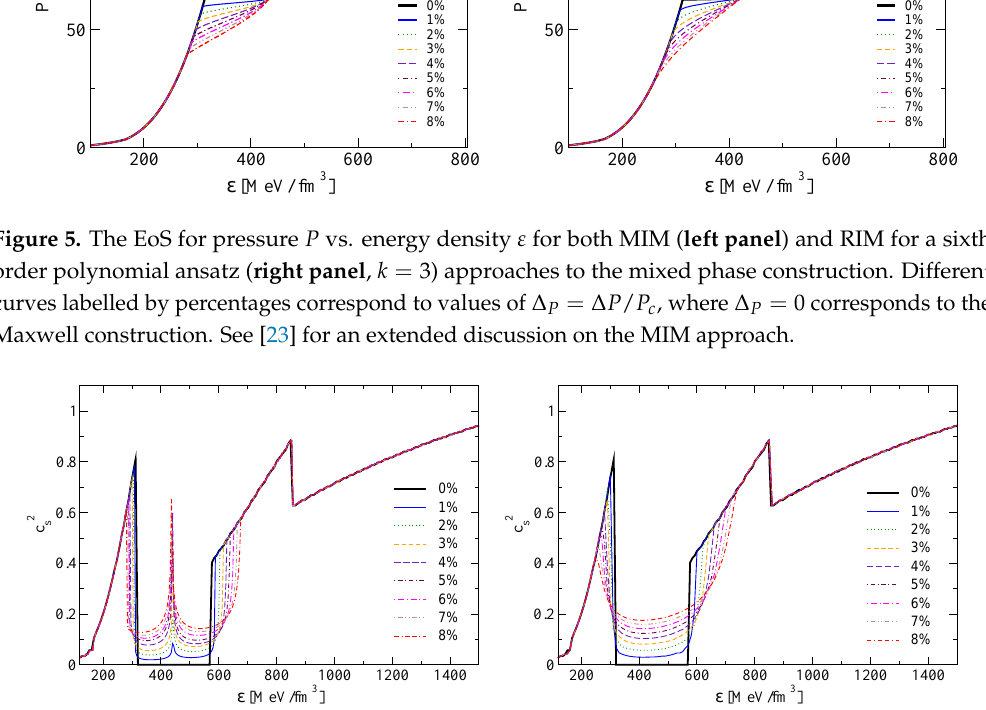
Figure 6. The squared speed of sound c 2 s against energy density ε for both MIM ( left panel ) and RIM ( right panel , k = 3) approaches to the mixed phase construction. Different curves labelled by percentages correspond to values of ∆ P = ∆ P / P c , where ∆ P = 0 corresponds to the Maxwell construction. A clear feature of the MIM that distinguishes it from the RIM is the intermediate stiffening of the EoS, apparent by the peaked structure inside the mixed phase region. See [23] for an extended discussion on the MIM